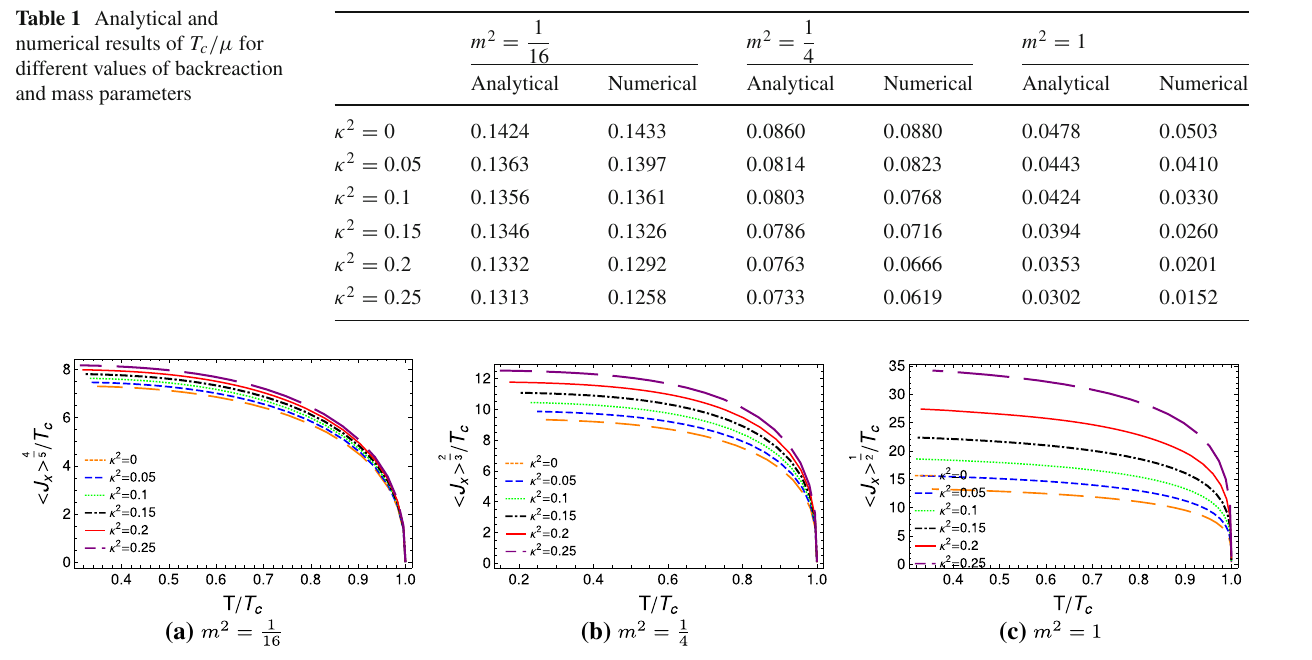
Fig. 1 The behavior of the condensation parameter as a function of the temperature for different values of backreaction